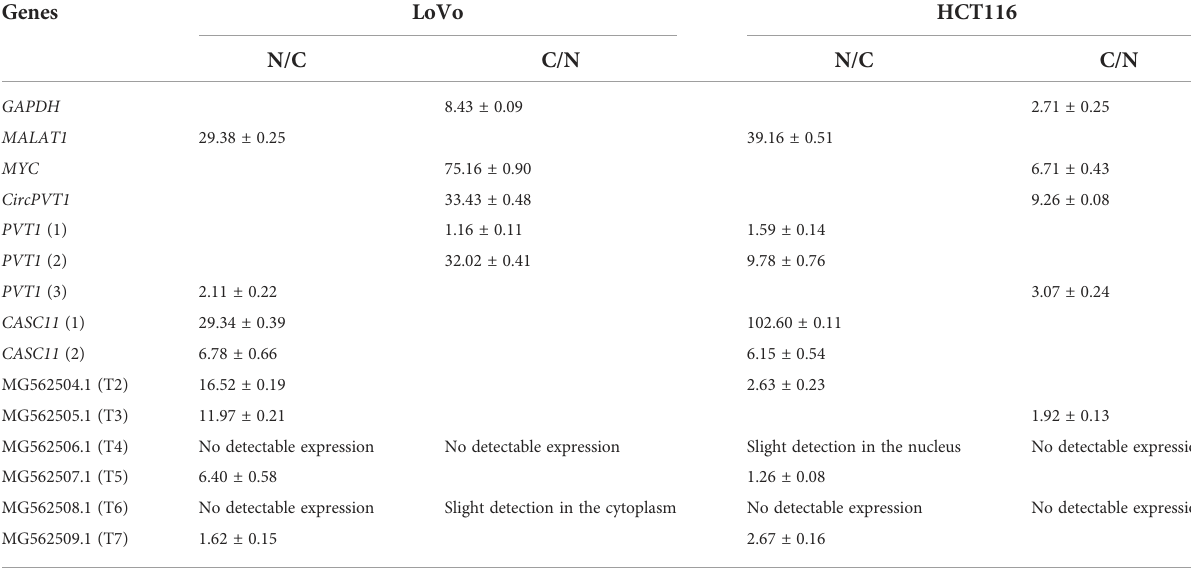
TABLE 1 Fold changes of MYC , PVT1 , and CASC11 in the nucleus to the cytoplasm (N/C) and cytoplasm to nucleus (C/N) parts. Genes